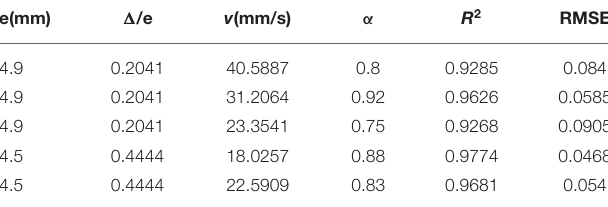
TABLE 3 | Parameter fitting of the FADE model with different mean flow rates under two groups of same relative roughness fracture